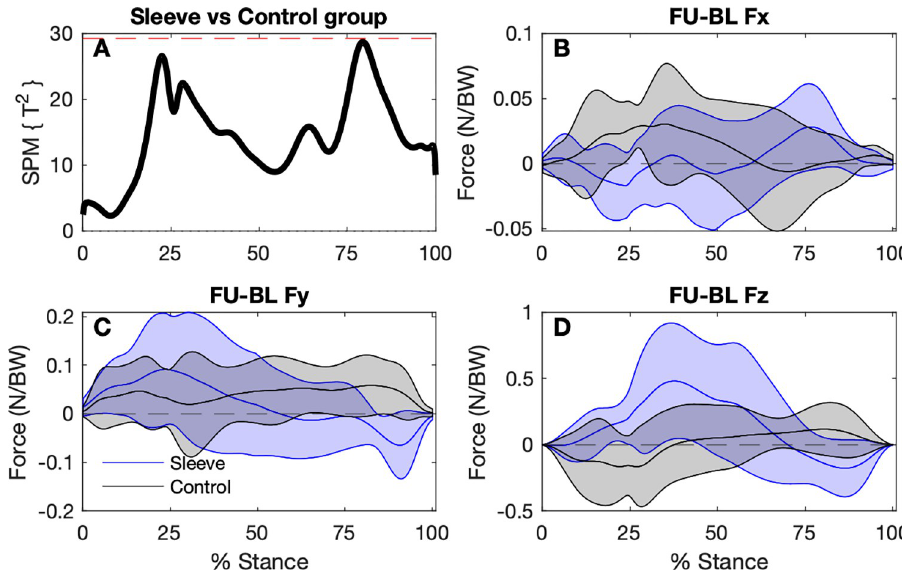
Fig 6. SPM analysis of ground reaction force trajectory differences between baseline and follow-up for the Sleeve group (n = 9) and Control group (n = 9). A. Hotellings T 2 test trajectory. The dashed red line indicates adjusted significance criterion. B–D. The x, y, and z component curves (mean and ± 1 standard deviation bands) comparing groups. Positive values indicate increases in values from baseline to